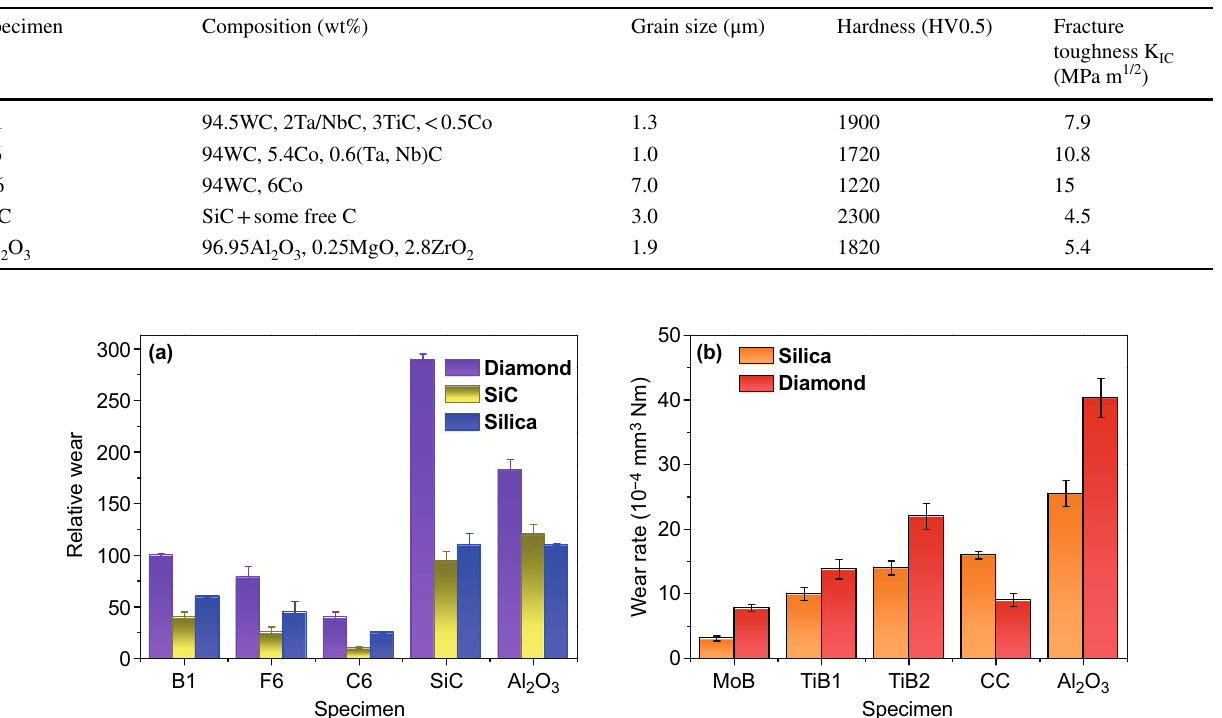
Table 7 Composition, grain size, hardness, and fracture toughness of the tested materials [188]